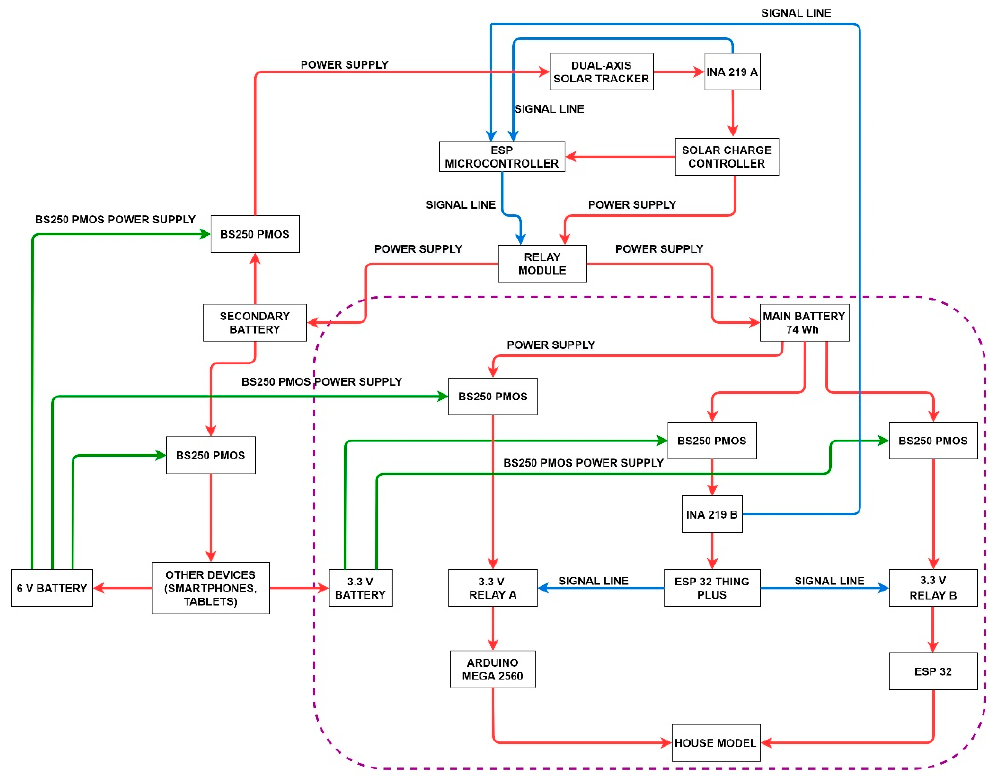
Figure 1. Proposed Energy Management Block Diagram for the Solar-Powered Smart Home Automation